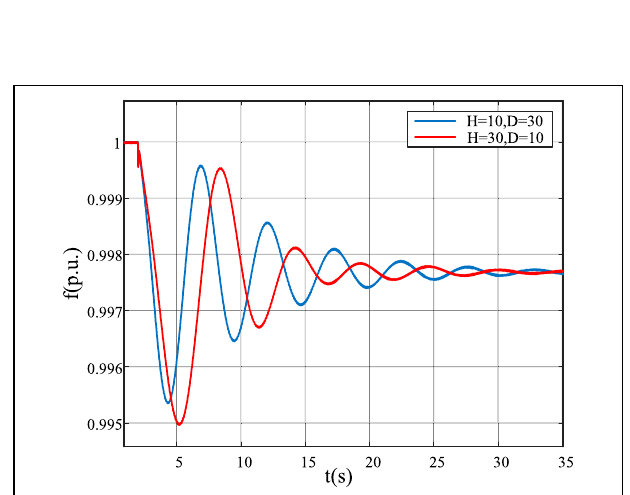
FIGURE 17 | Frequency when the damping coefficient of the inverter changes in parallel connection.